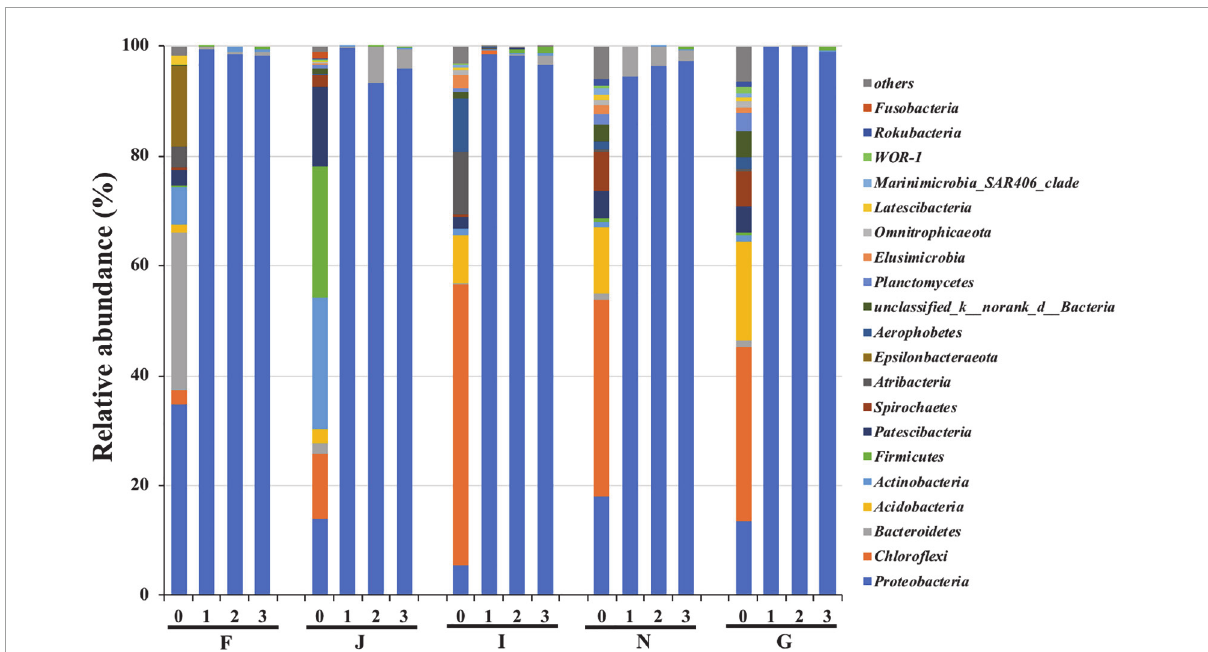
FIGURE2 Variations in bacterial community compositions at phylum level during enrichments. 0, 1, 2, and 3 represent cultures before, after the first, after the second, and after the third enrichment. F, J, I, N, and G refer to five different cultures derived from five surface sediments.